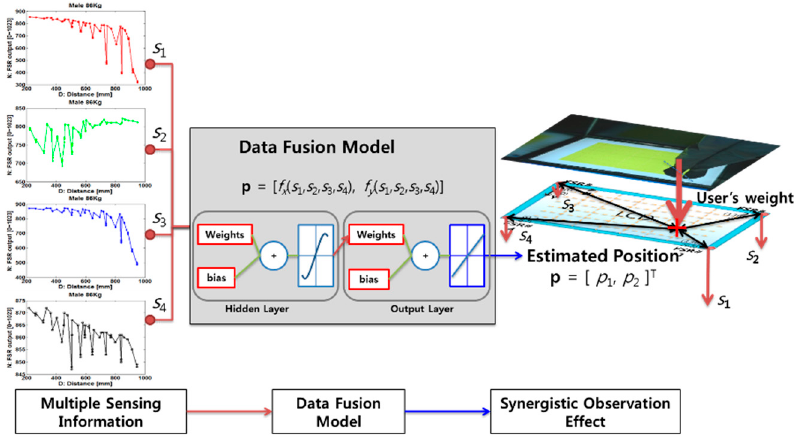
Figure 2. Example of user localization using a multi-sensor system.